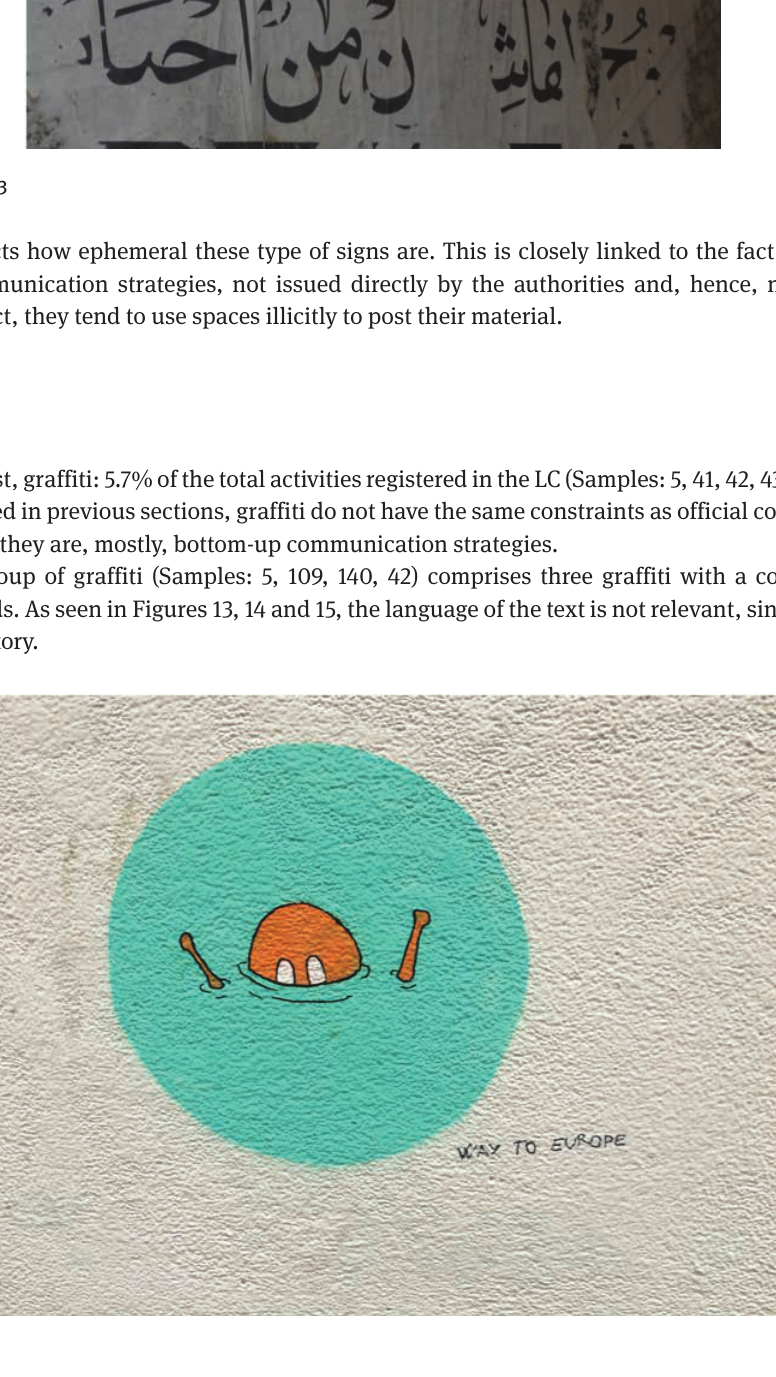
This Figure portrays a humanoid figure drowning in the sea, together with the legend: “Way to Europe” (English original). This graffiti protests against the death of immigrants who try to cross de